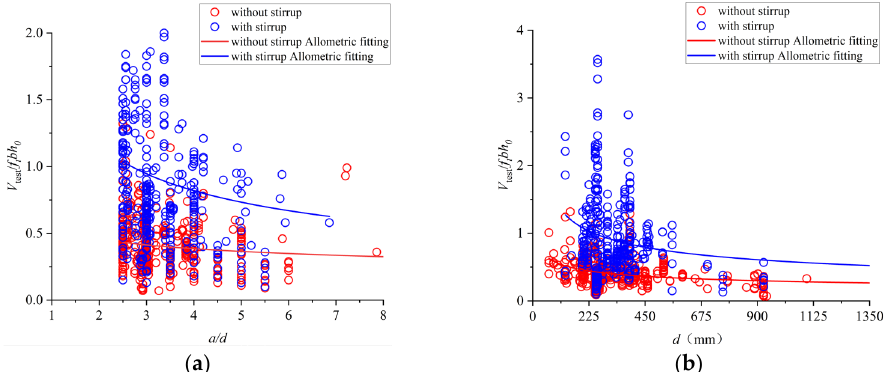
Figure 5. Normalized shear strength versus key parameters: ( a ) shear span-to-depth a / d and ( b ) effective depth d .